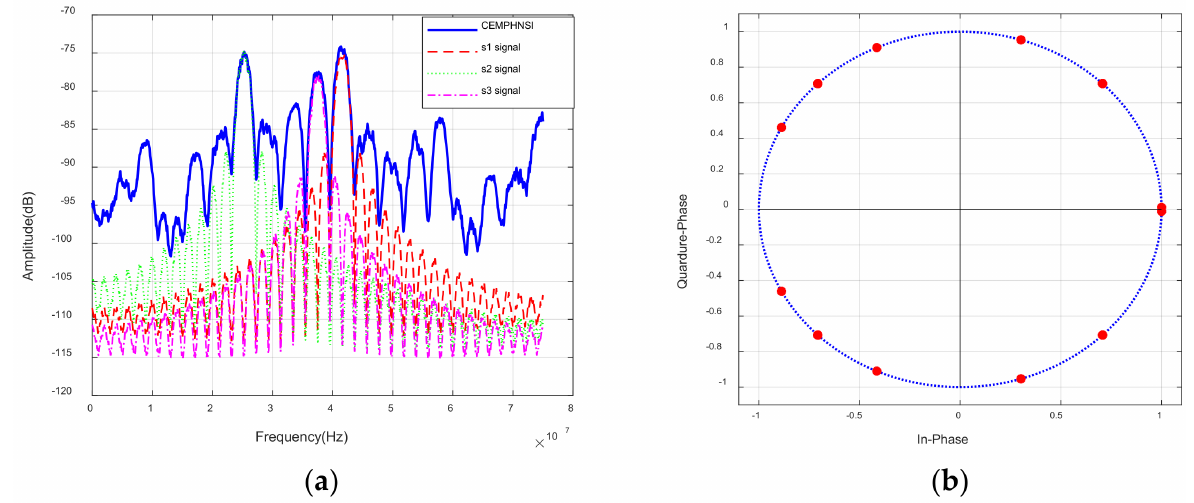
Figure 5. ( a ) The spectrum of CEMPHNSI and multiplexed signals; ( b ) The constellation of CEMPHNSI.